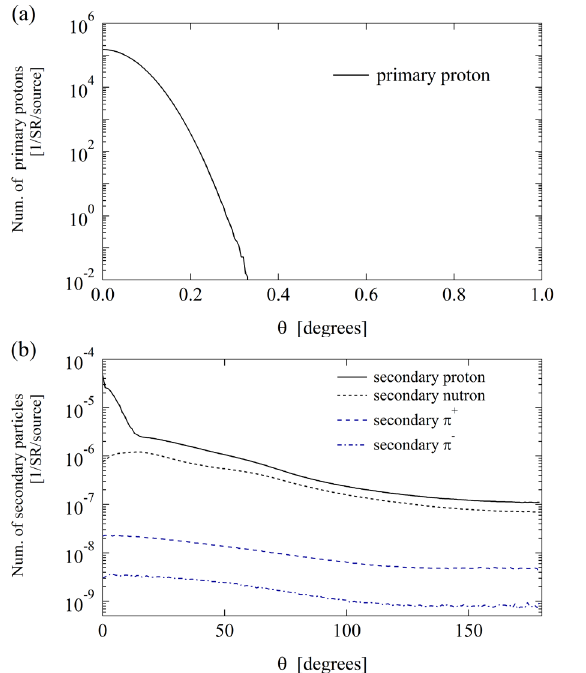
Fig. 5. Angle distribution of primary proton (a) and secondary particles (b) calculated using PHITS code.